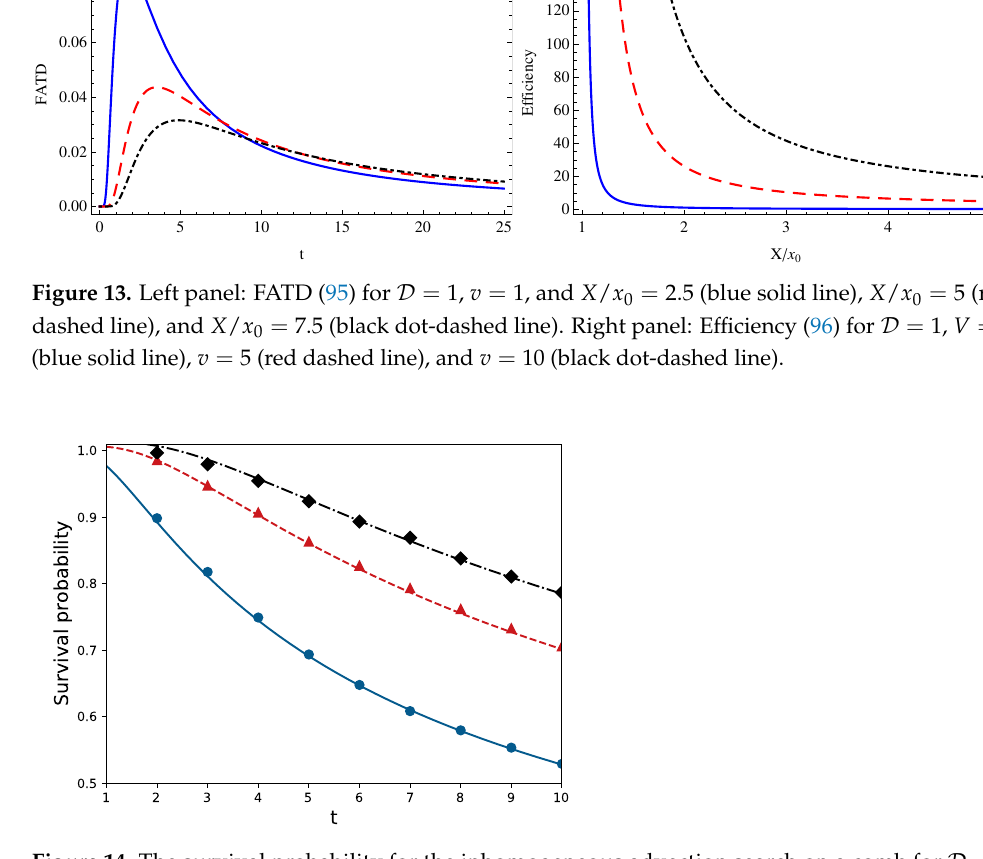
Figure 14. The survival probability for the inhomogeneous advection search on a comb for D = 1, v = 1, and X / x 0 = 2 (blue solid line), X / x 0 = 5 (red dashed line), and X / x 0 = 10 (black dot-dashed line).The numerical results are represented by dots, triangles, and